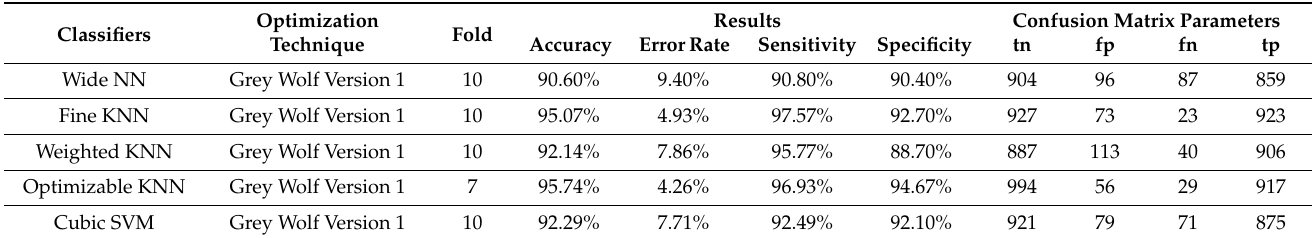
Table 3. Performance of various classifiers using GLRLM and statistical features.